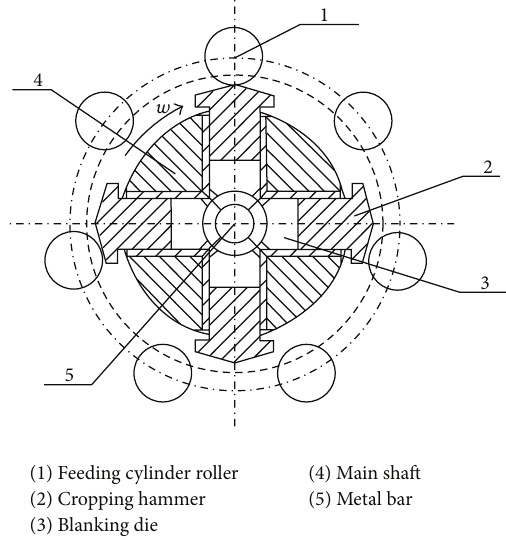
Figure 1: The work principle of fatigue radial-forging